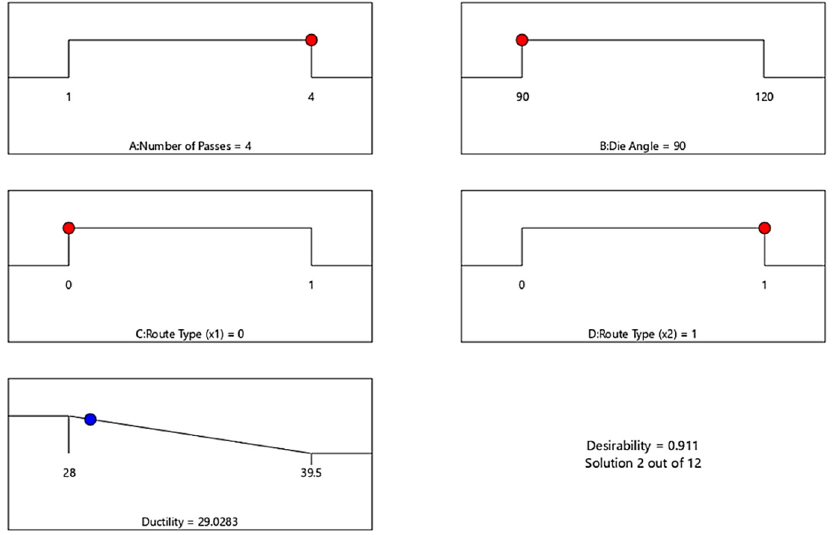
Figure 15. Optimal ECAP process parameter of D. Red dots: ECAP condition. Blue dots: ECAP re- sponse.